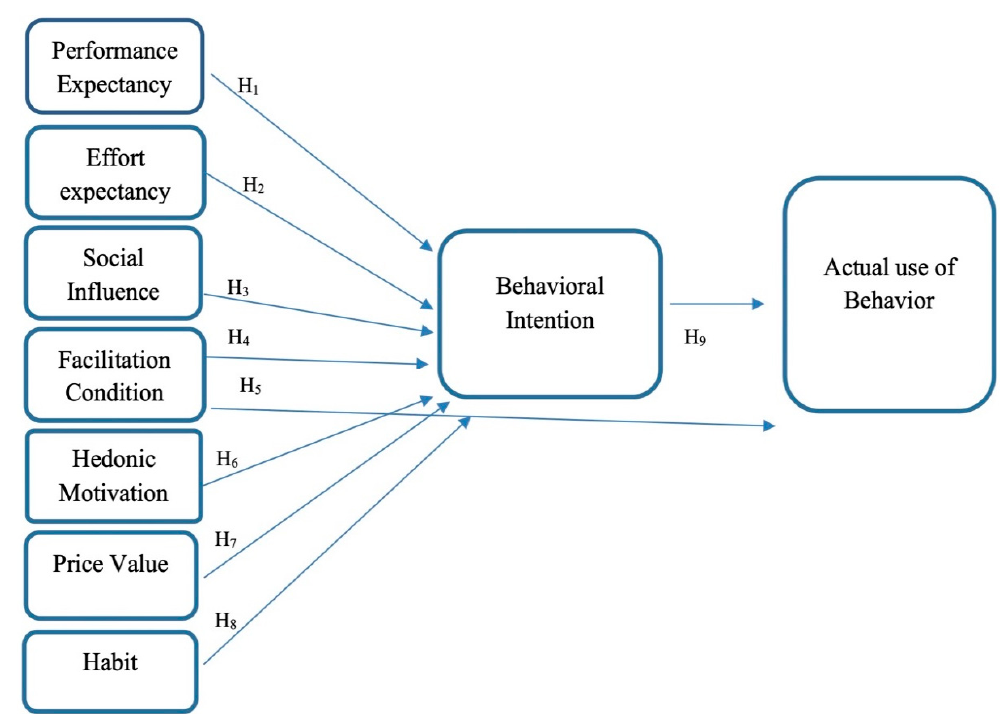
Figure 1. Proposed Theoretical Research Method Adapted from UTAUT2.